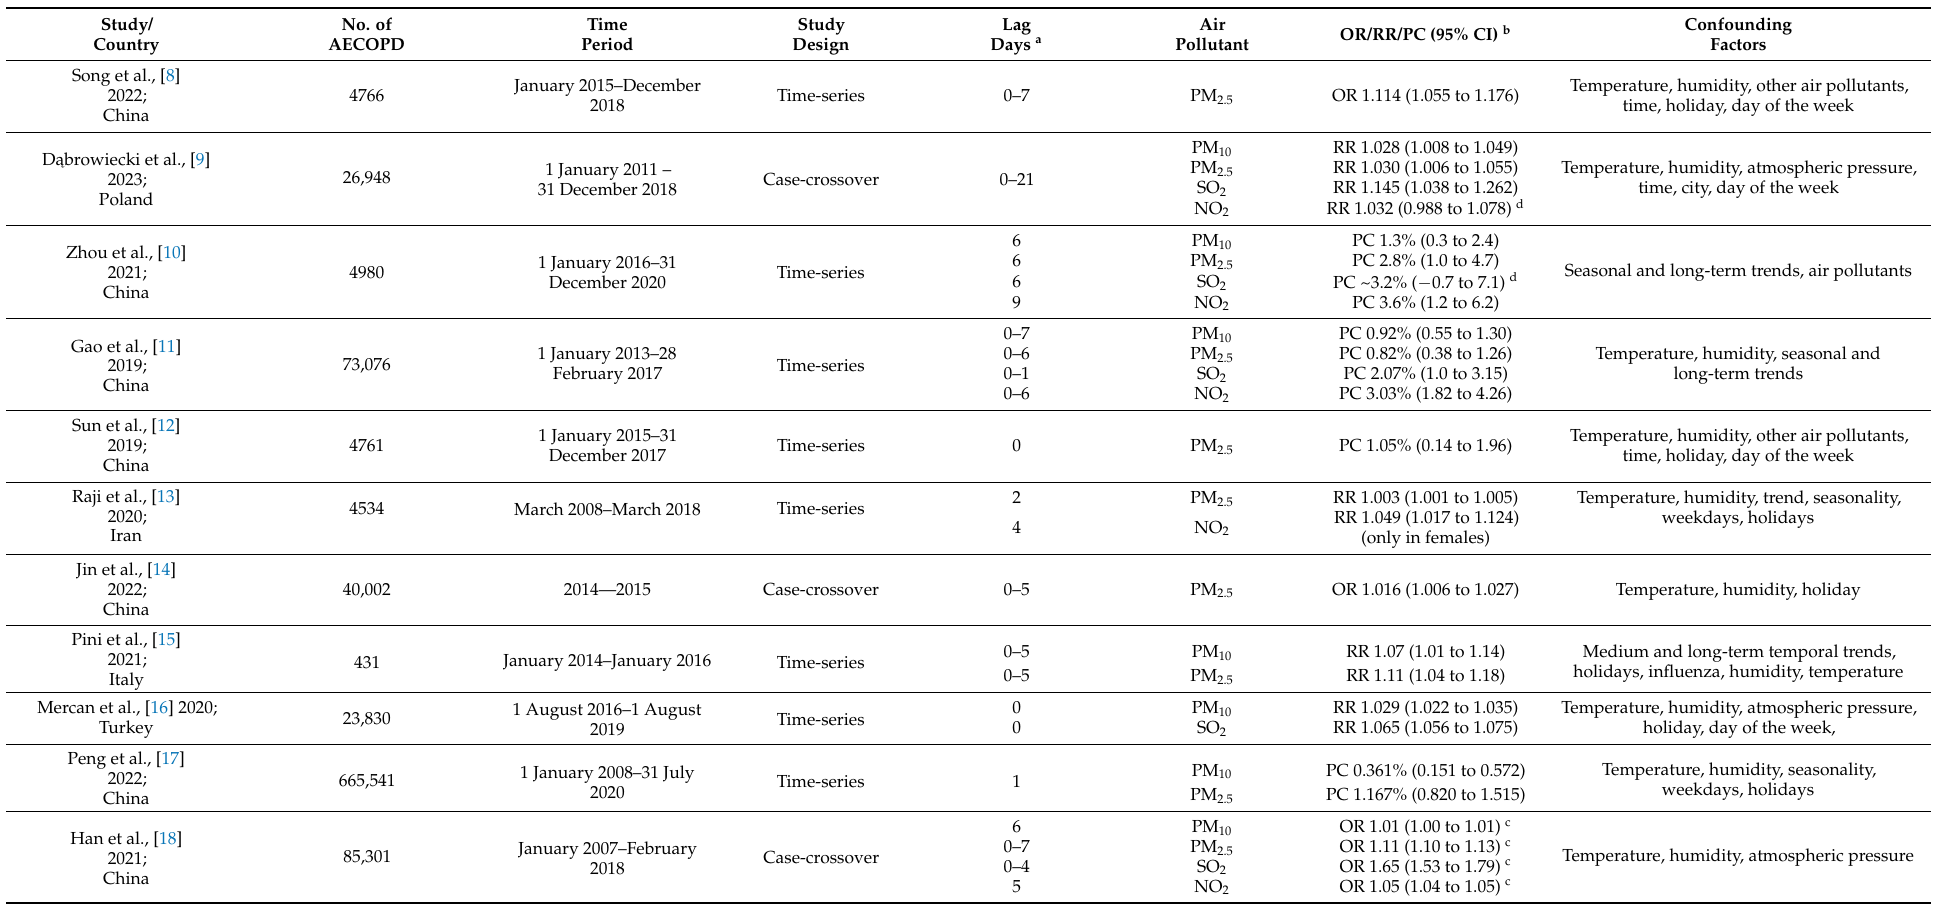
Table 5. Selected studies demonstrating a positive association between air pollutant exposure and number of AECOPD